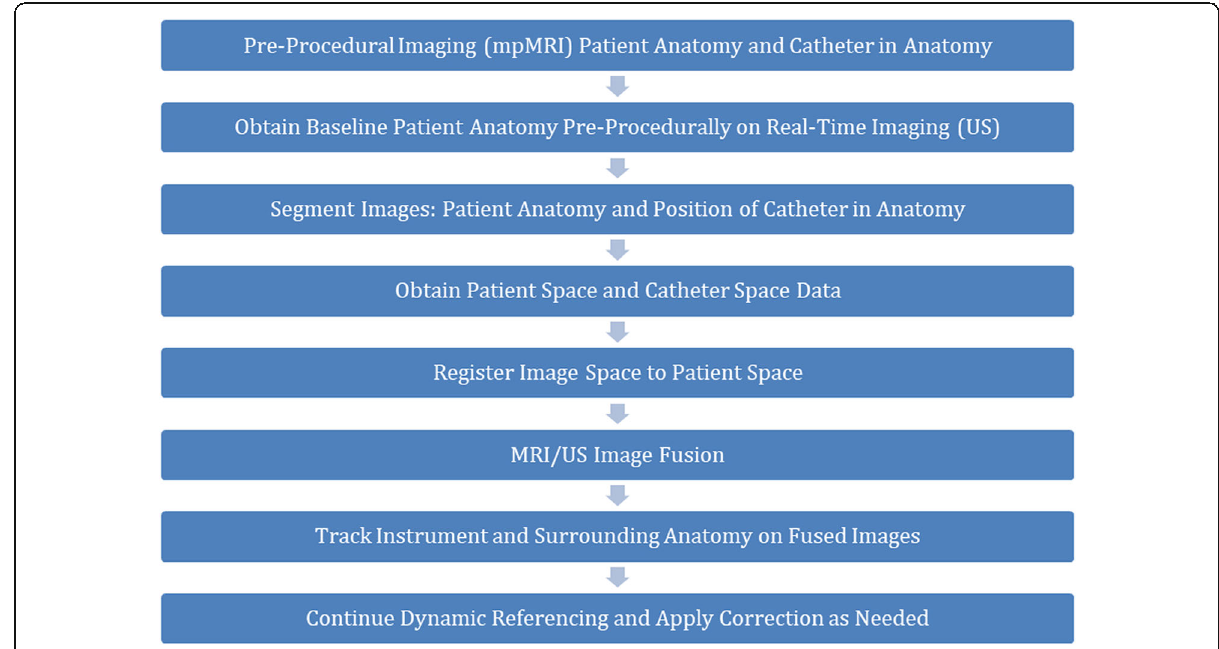
Fig. 1 Workflow incorporating the tracked Foley